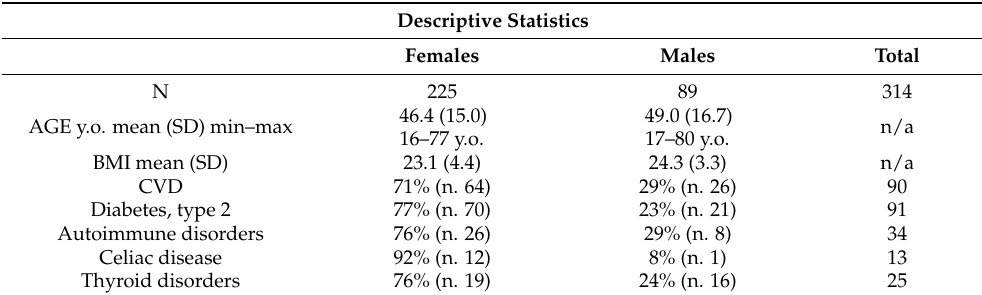
Table 1. Epidemiological findings of the study population (BMI—body mass index; CVD— cardiovascular disease; N—number; SD—standard deviation; and y.o.—years